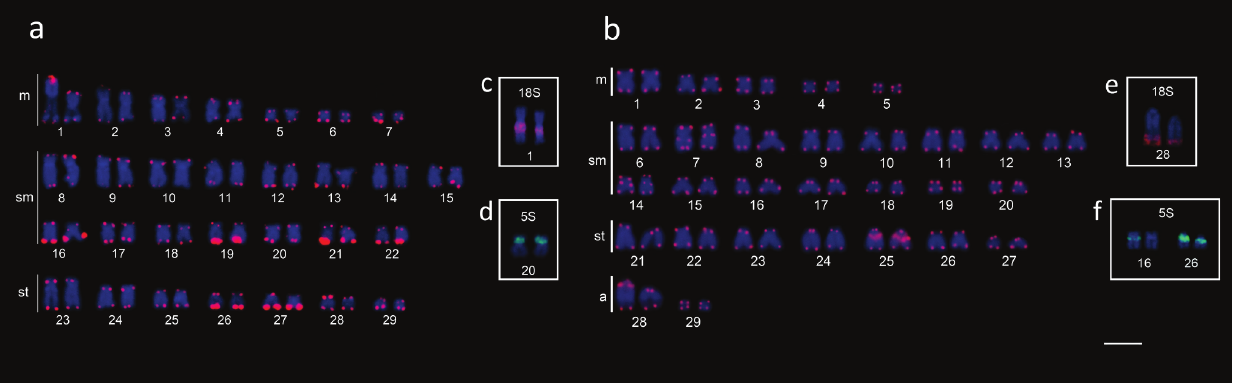
Fig. 2. Karyotype of Farlowella cf. amazonum : (a) telomeric sequences, (c) 18S rDNA, and (d) 5S rDNA. Karyotype of Farlowella schreitmuelleri : (b) telomeric sequences, (e) 18S rDNA, and (f) 5S rDNA. Scale bar = 10